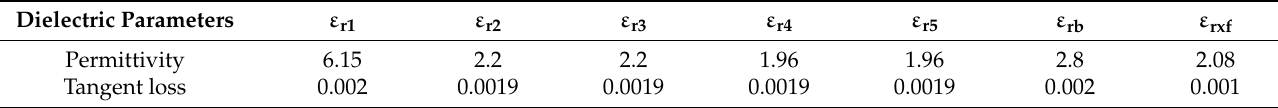
Table 2. PUMA Array Dielectric